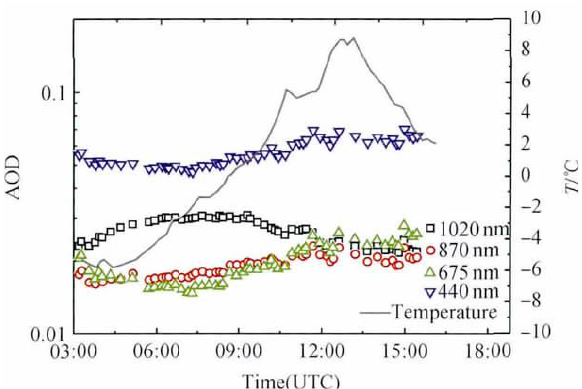
Fig. 2 Time variation of aerosol optical depth and temperature at different wavelength at Vechernaya_Hill site in the Antarctic (extract the figure 1 from Li et al.,